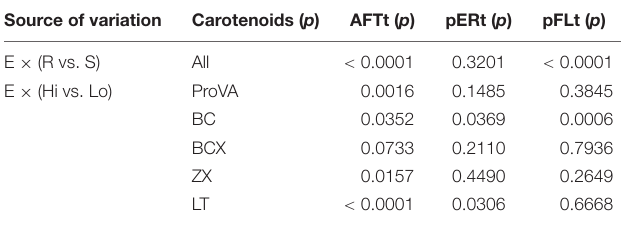
TABLE 6 | Probabilities of significance ( p ) for F -tests for interaction contrasts of environment (E) by hybrids of aflatoxin resistant (R) vs. susceptible (S) testers, and for E by hybrids with high (Hi) vs. low (Lo) carotenoids concentrations for aflatoxin concentration in grain [AFTt, log(AFT + 1)], A. flavus ear rot symptom scores [pERt, sqrt(pER)], and A. flavus colonization of grain measured by bright greenish yellow fluorescence scores [pFLt, sqrt(pFL)] for analyses of variance across five (AFTt) or four (pERt and pFLt) trial